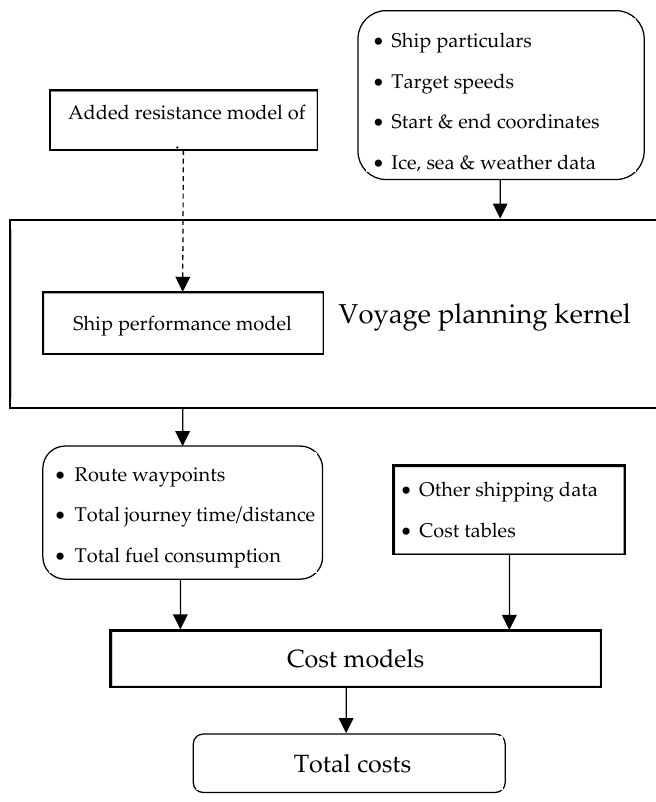
Figure 2. Flowchart of the Voyage Planning Tool.